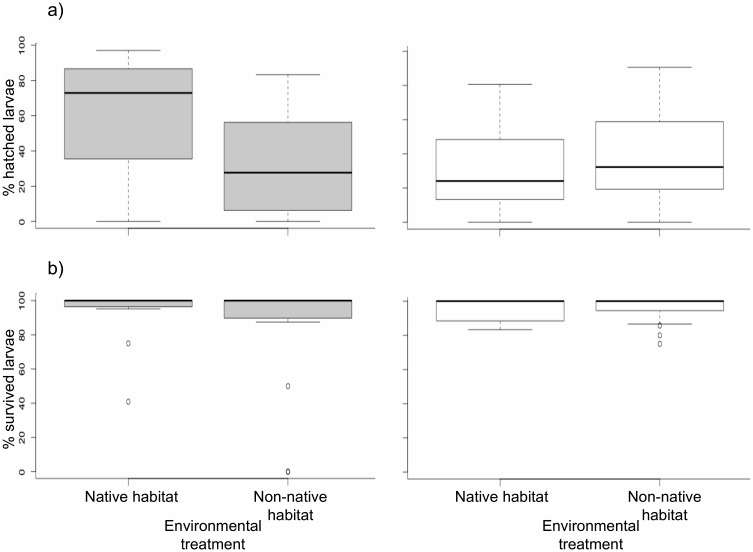
Within- and between-population comparisons of a) hatching success (%) and b) survival through yolk sac phase (%) for E. lucius reared in native and non-native environments using a reciprocal translocation experiment.The boxes are indicated with habitat treatment (native vs non-native) and population origin with grey colour for Okne and white colour for Lervik. The solid lines within the boxes indicate medians, the boundaries of the box indicate 25th and 75th percentiles, whiskers below and above indicate 10th and 90th percentiles, and dots indicate outlying observations.